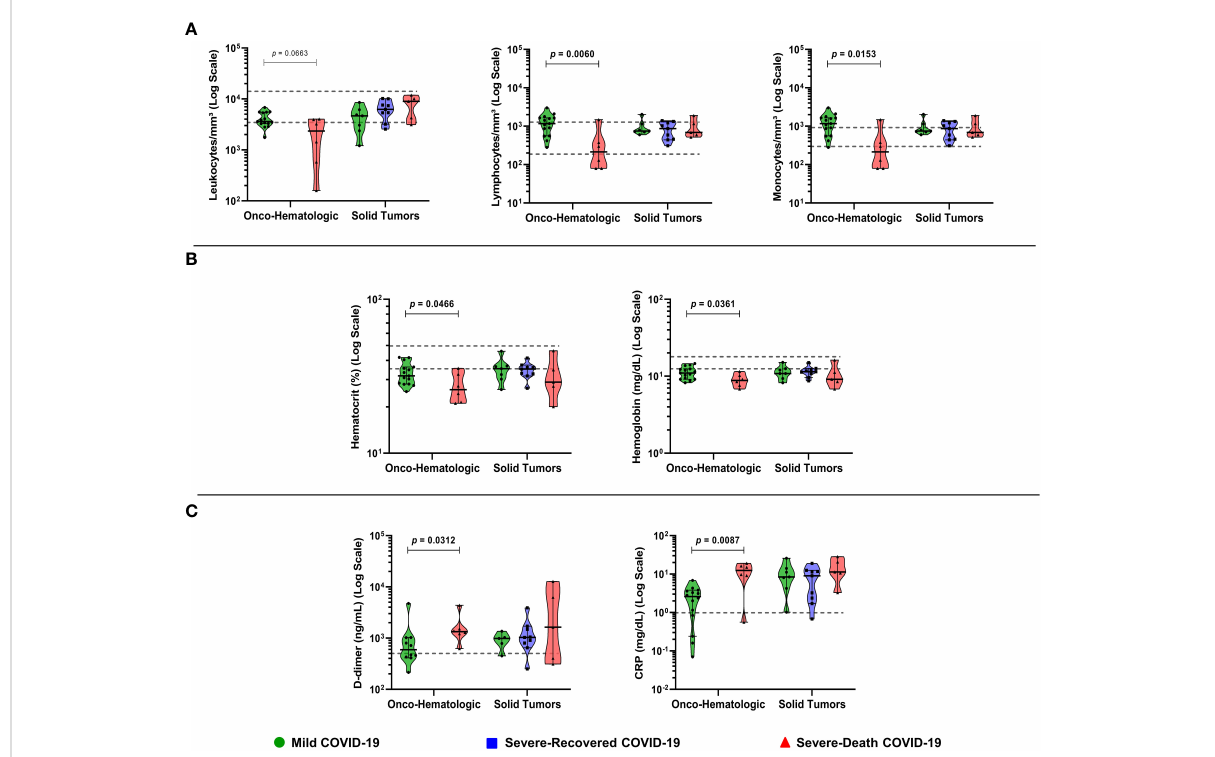
FIGURE 2 Biochemical and hematological analysis of plasma reveals that low numbers of leukocyte subpopulations are associated with death in patients with hematologic malignancies. Blood samples were collected within two days (median; 1 – 4 CI) of the positive SARS-CoV-2 diagnosis, while hemogram and biochemical exams data were gathered from electronic health records. The graphs depicts leucocytes and subpopulations (A) , hematologic parameters (B) , and biochemical parameters (C) . Groups were de fi ned based on disease severity, as Mild (green), Severe- Recovered (blue), or Severe-Death (red), as described. Gray dashed lines indicate the reference value ranges for each exam. Data is presented as median plus 95% con fi dence intervals and was analyzed with Kruskal-Wallis adjusted for multiple comparisons followed by Dunn ’ s post-hoc test or Mann-Whitney test. All exact p -values below 0.1 are shown. CRP, C-Reactive Protein; N = 21 for Onco-hematologic and N = 22 for Solid tumors